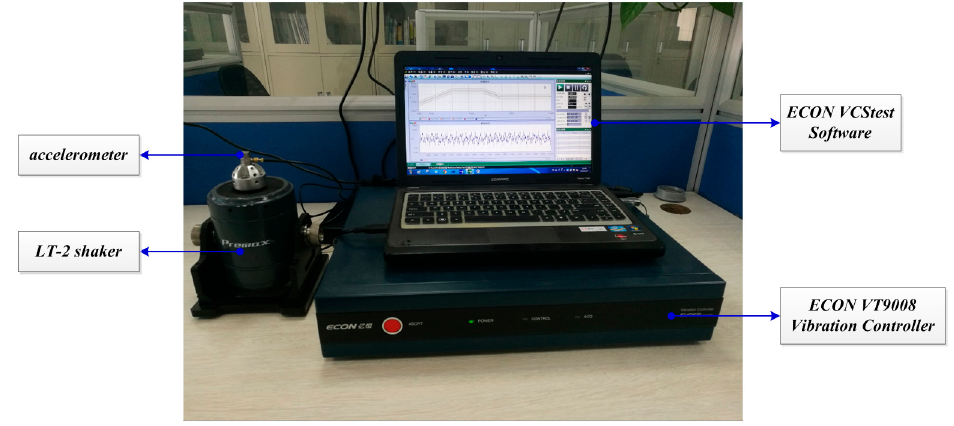
Figure 4. The experimental devices.